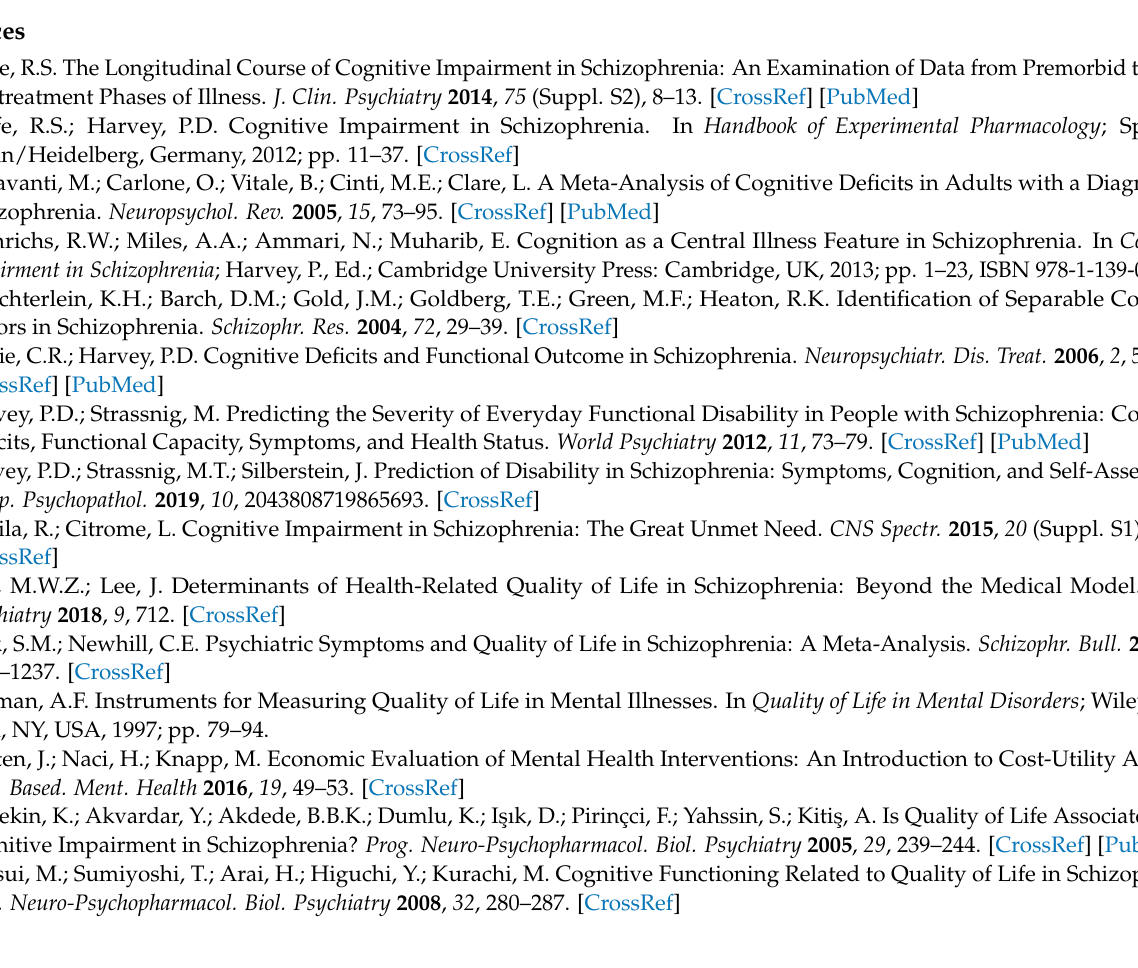
Figure A1. Cognitive Architecture of Individuals with Schizophrenia.